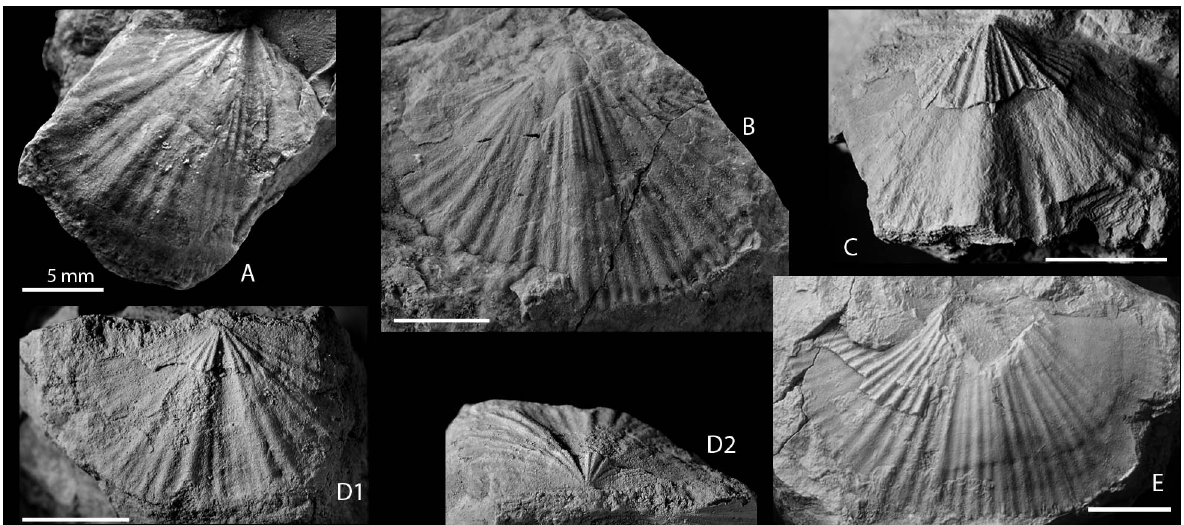
Fig. 7. A(cid:150)E , Reuschella sp. Porkuni Stage, ˜rina Formation, Tırevere Member. A, exterior of incomplete dorsal valve TUG 101-79; Tırevere quarry. B, exterior of ventral valve TUG 47-680; Porkuni quarry. C and D, exterior fragment and mould of ventral valve TUG 101-81A, and fragment and mould of dorsal valve TUG 101-81B with posterior view; Tırevere quarry. E, mould of ventral valve GIT 626-186; erratic boulder of reef limestone,